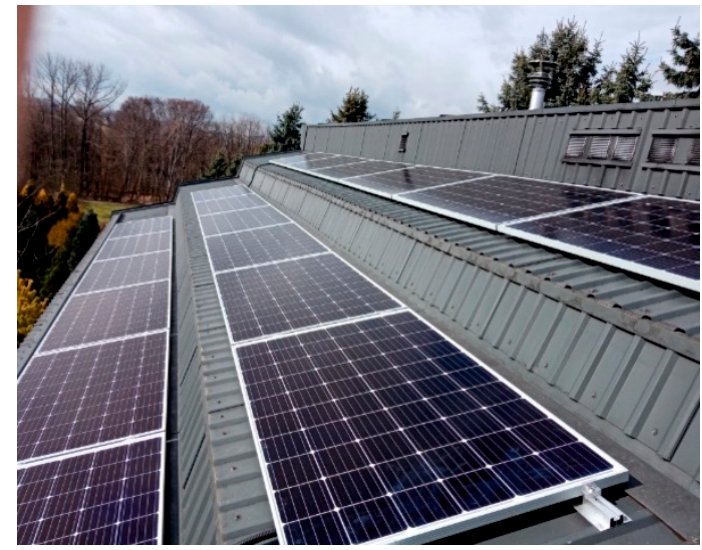
Figure 8. Stepped roof with PV monocrystalline photovoltaic panels installed at the recommended angle of 15°. Location: 49°57 ′ N, 19°55 ′ E (photo by W. Celadyn).